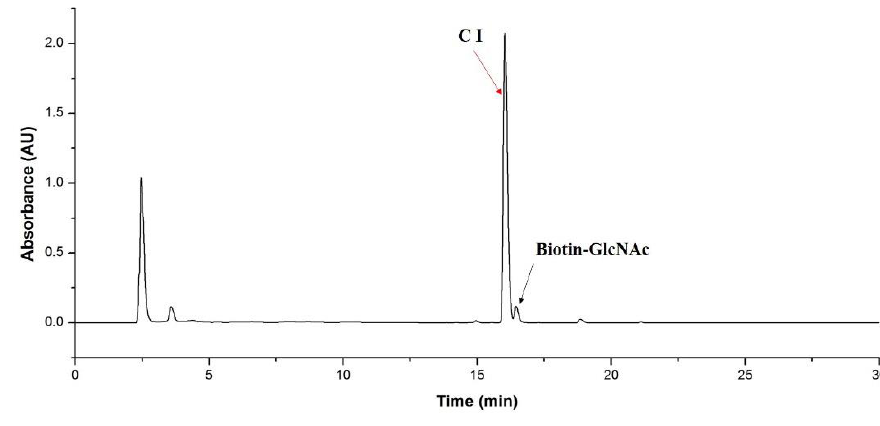
Figure 1. HPLC analysis of OPME 1-catalyzed synthesis of compound I (C I). Table 1. Yields of three OPMEs by di ff erent